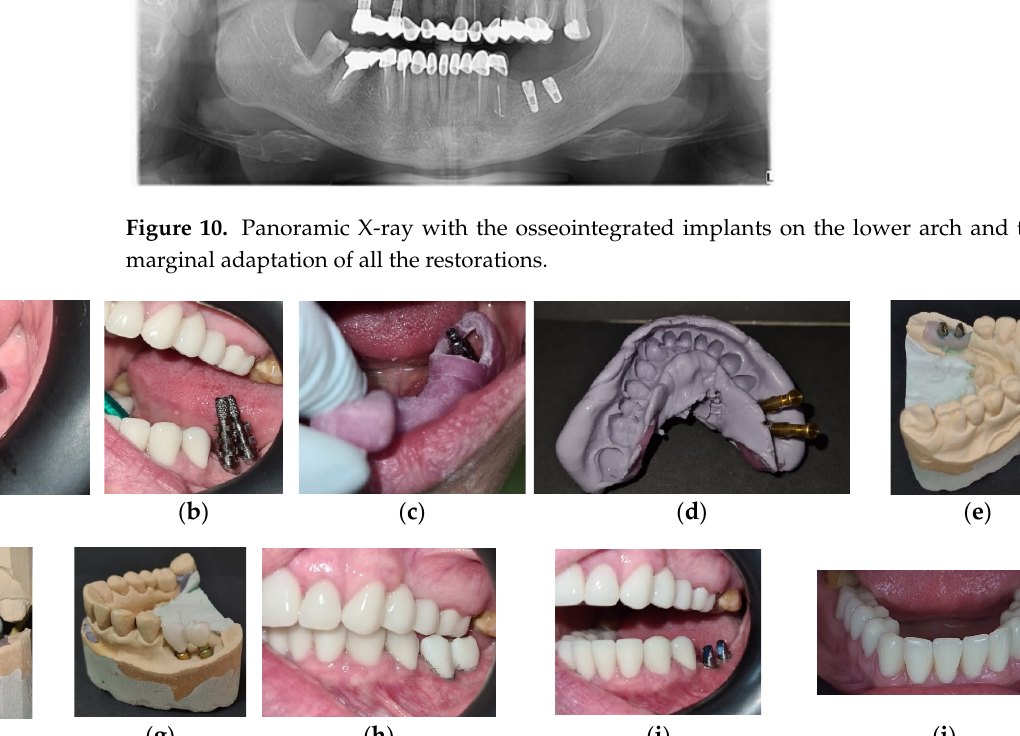
( a ) ( b ) ( c ) Figure 12. The final result of the full-mouth rehabilitation: ( a ) Intraoral aspect of the restorations; ( b ) The improved smile with minimal gingival display; ( c ) Panoramic X-ray after one year. 3. Discussion Several studies have demonstrated the need for these surgical interventions to obtain an aesthetic smile, predominantly in the case of female patients [16], as in the presented case. The patient’s initial problem was the gingival smile with the visibility of unaesthetic metal-ceramic prosthetic works. In this situation, resolving the patient’s primary problems was possible only by performing full-mouth rehabilitation. The surgical correction of the upper clinical crown:root ratio and gingival displacement was necessary before the prosthodontic approach. According to Narayan et al., the pretreatment planning included a complex clinical evaluation regarding: •